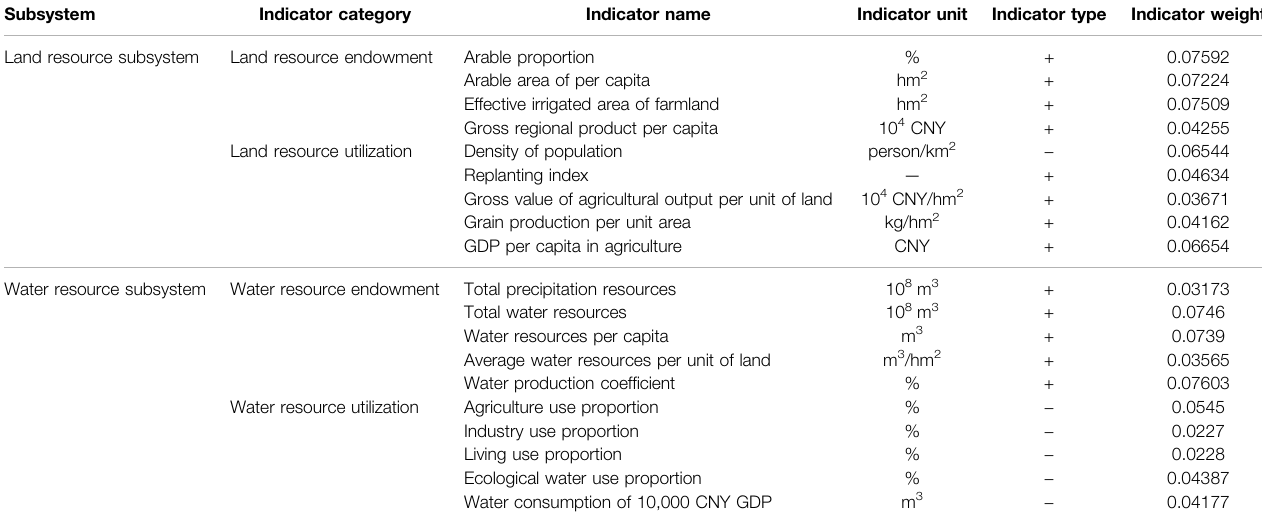
TABLE 2 | Coupling coordination degree evaluation index system.